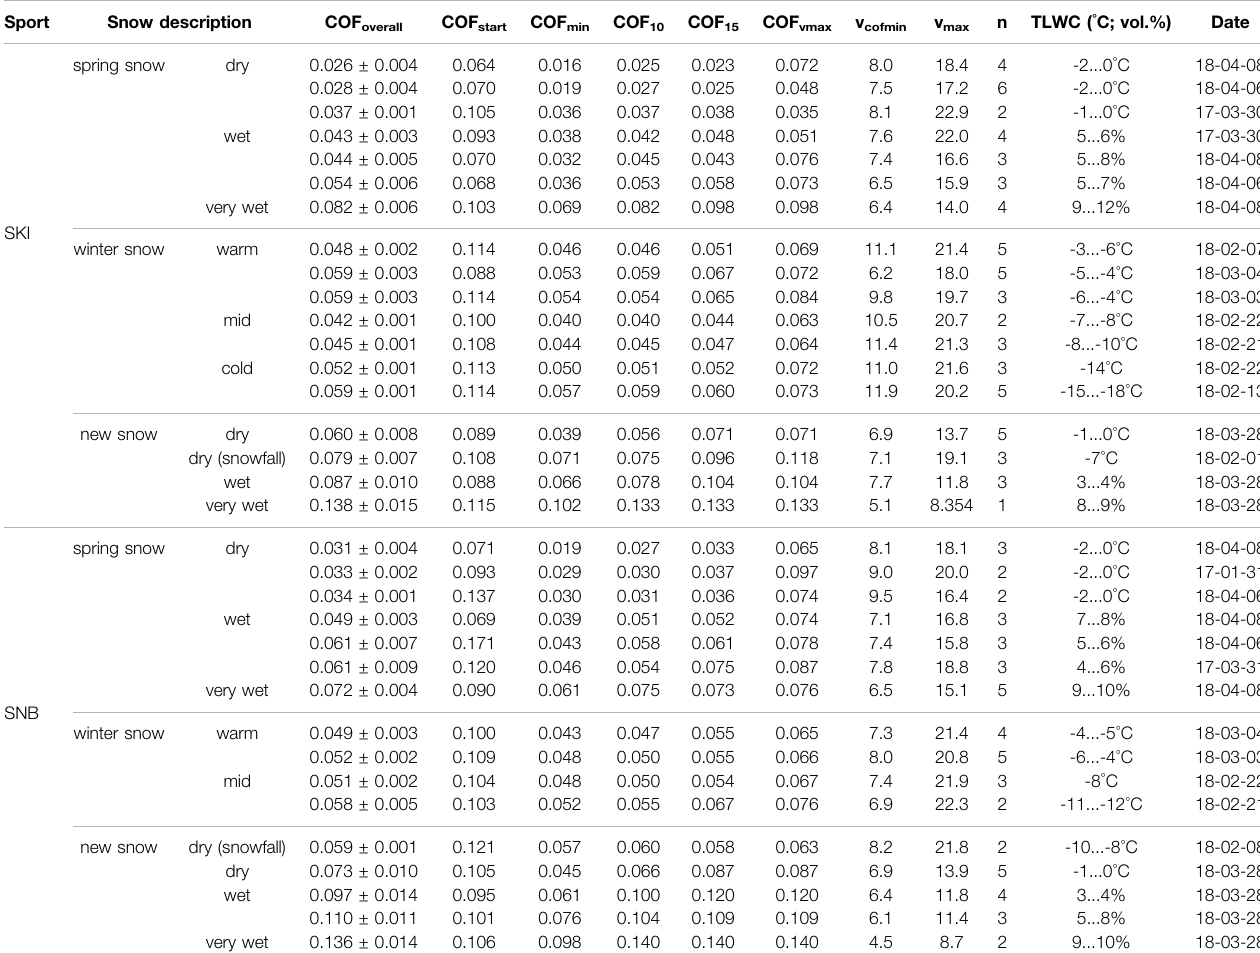
TABLE 5 | Friction coef fi cients averaged over 2 to 6 consecutive runs with constant snow conditions, categorized into spring, winter and new snow with different snow temperatureorsnowwetnesssub-categories.TheoverallCOFs(mean ± σ )wereaveragedfrom5to15 m s − 1 .InstantaneousCOFvaluesatthestart(after4 mofgliding; COF start ), when reaching the minimum COF (COF min ), at 10 m s − 1 (COF 10 ), 15 m s − 1 (COF 15 ) and at maximum speed (COF vmax ), provide information on the COF speed dependency.